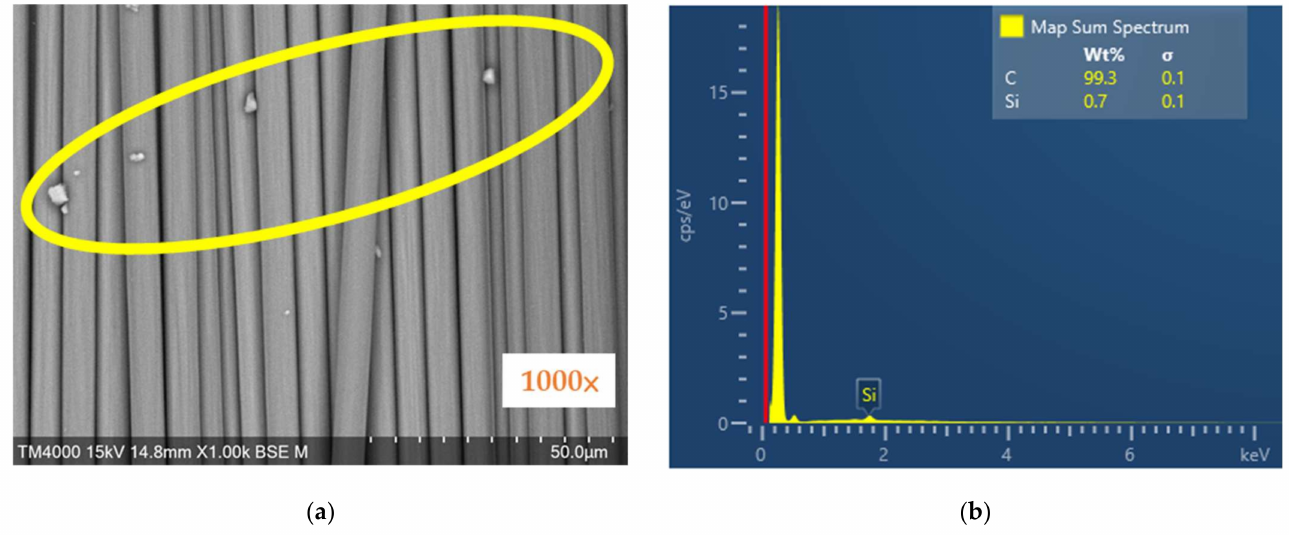
Figure 4. SEM observation of the surface of carbon fiber with the presence of coupling agent: ( a ) SEM image; ( b ) EDX graph.